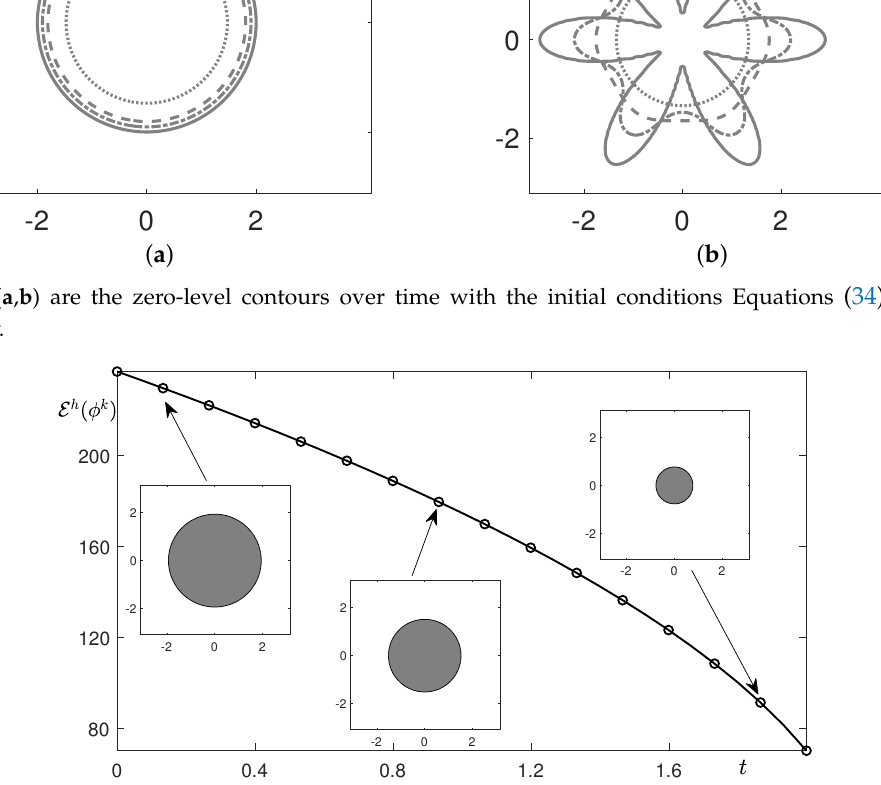
Figure 8. Energy dissipation over time to the AC equation with the initial condition (34) . The final time is T =